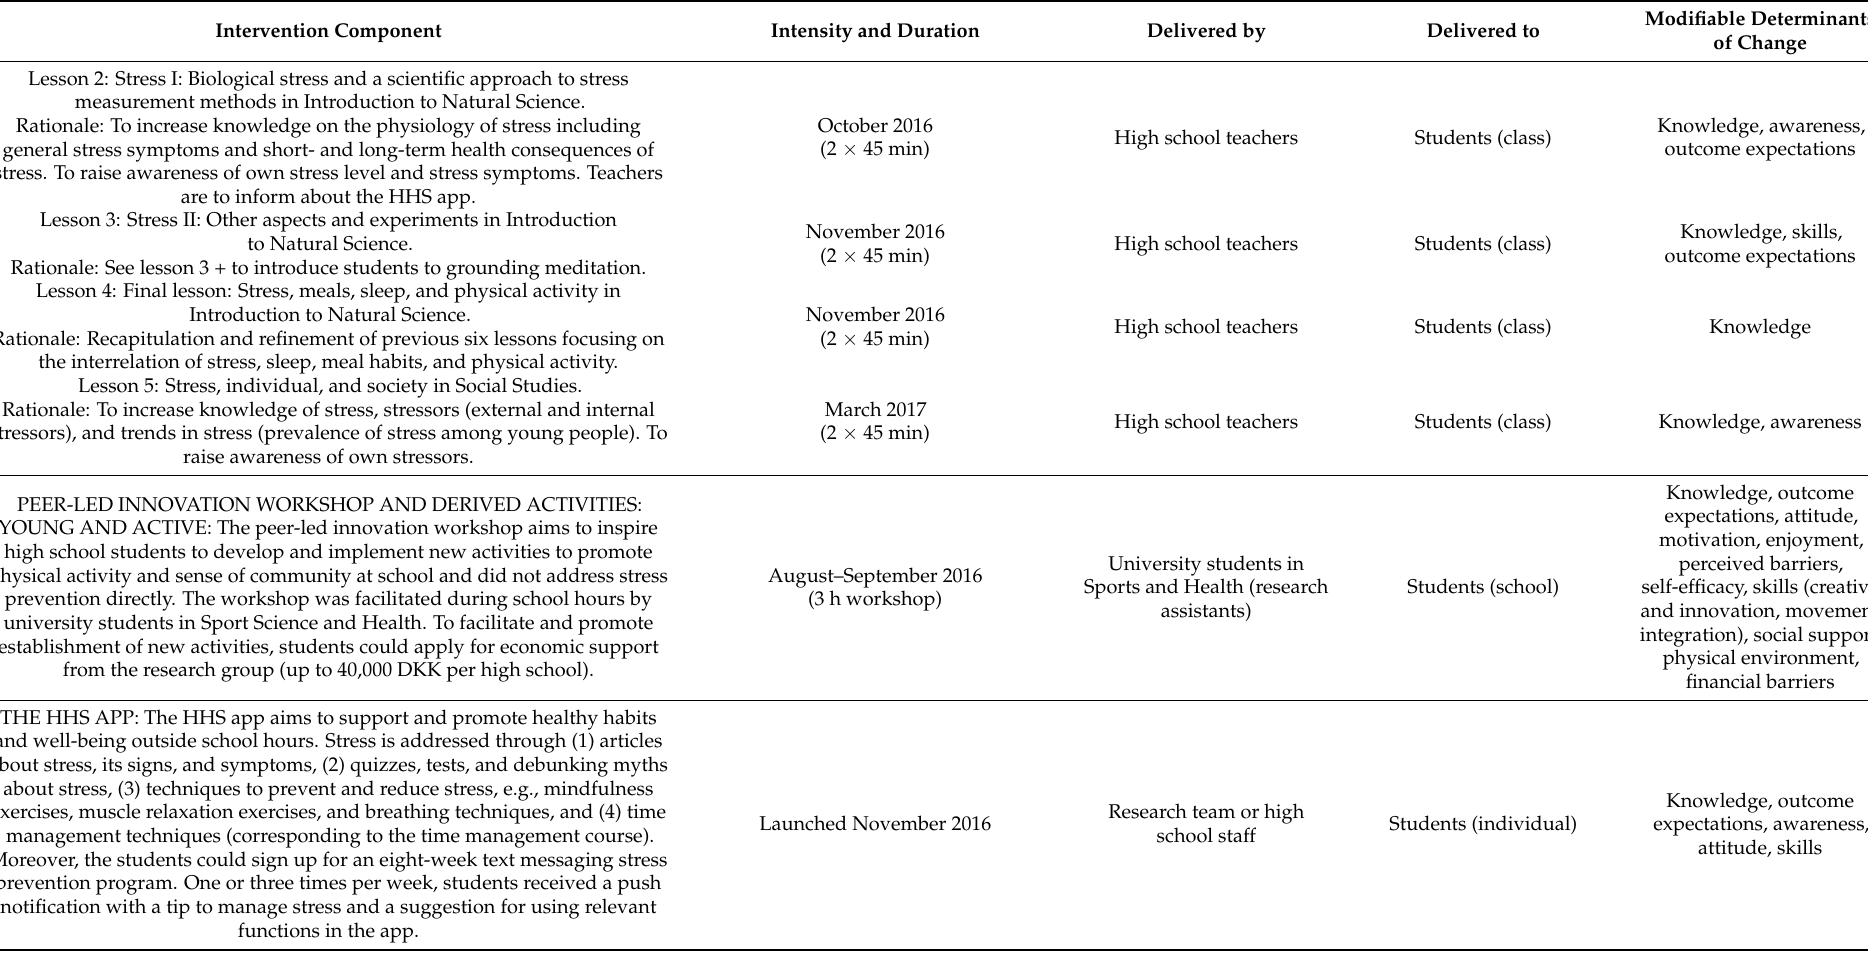
Intervention Component Intensity and Duration Delivered by Delivered to